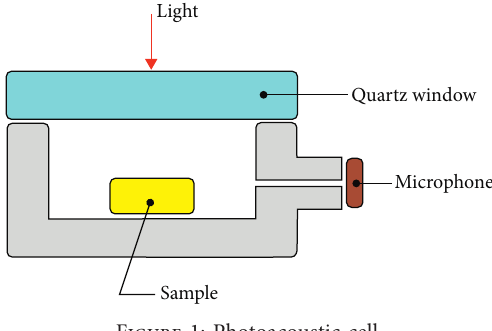
Figure 1: Photoacoustic